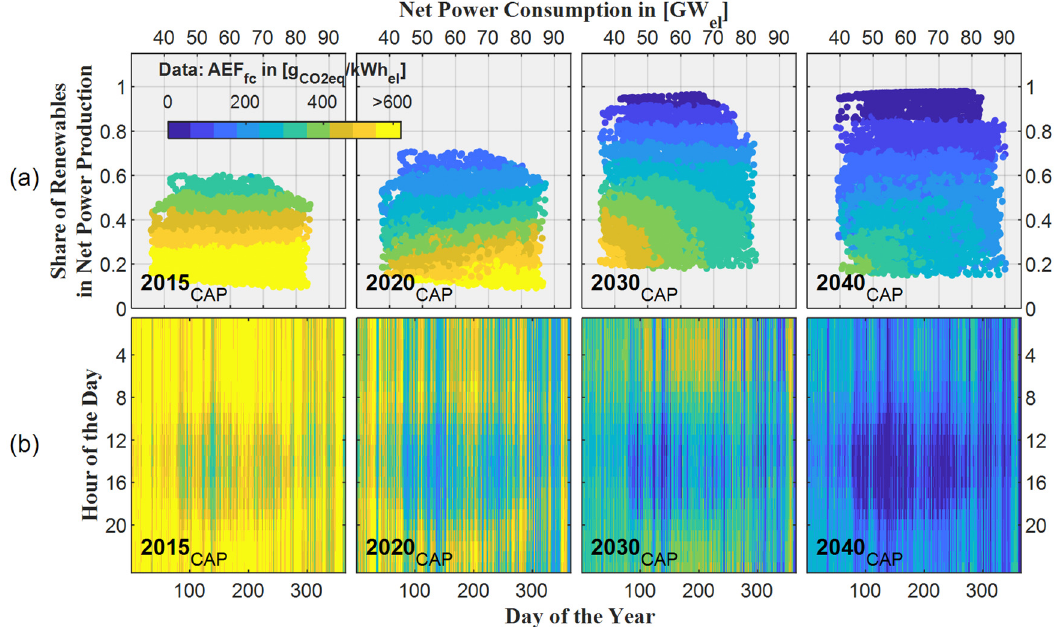
Figure 6. ( a ) Linkage of the AEF fc (color scale) with the share of RES in net power production and the simultaneously demanded load, the net power consumption; as well as ( b ) the temporal distribution of the 8760 AEF fc throughout the year as a heat map. Model results.